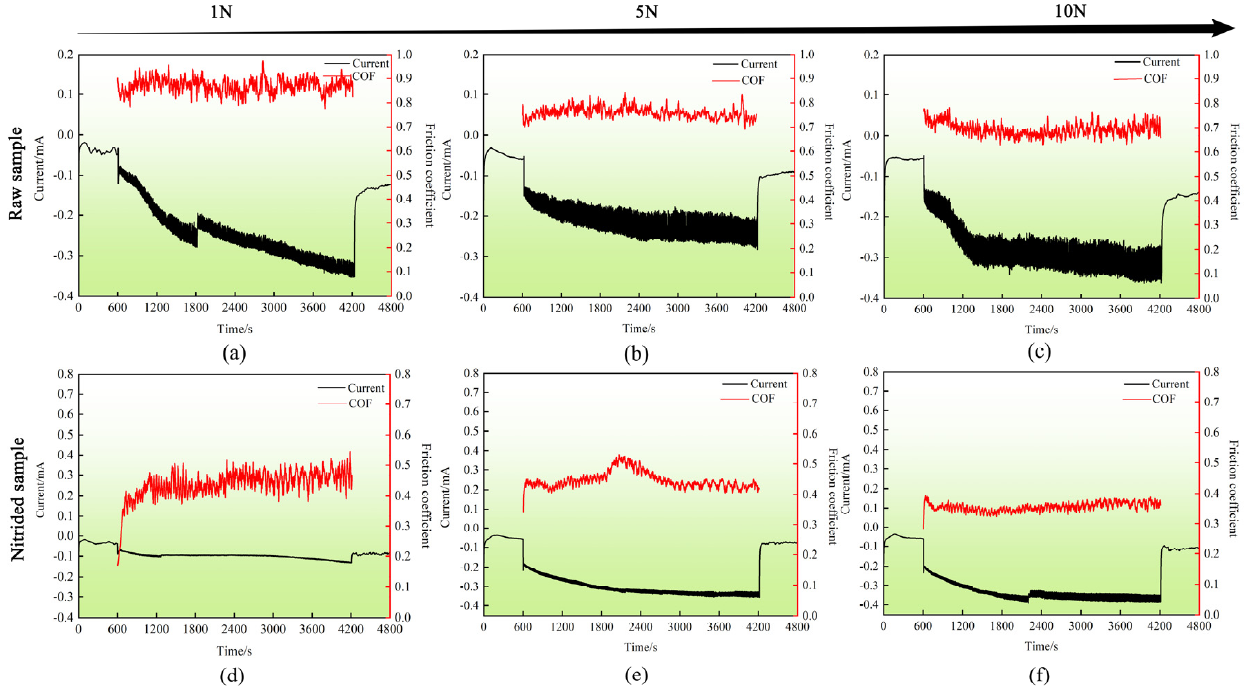
Figure 5. Evolution of the coefficient of friction (COF) and the current during the tribocorrosion test of the cathodic applied potential (E = − 1.2 V) for ( a–c ) Raw samples; ( d–f ) Nitrided samples.